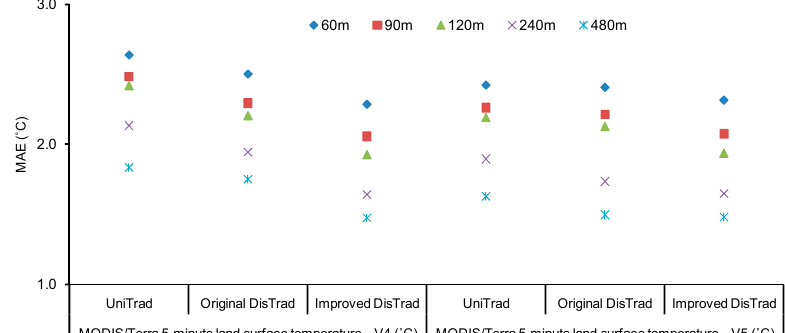
Figure 10. Mean Absolute Error (MAE) between downscaled products from MODIS/Terra 5-min land surface temperature (V4 and V5) using UniTrad, original DisTrad, and improved DisTrad, and observed Landsat 7 ETM+ land surface temperature at different resolutions (60, 90, 120, 240, and 480 m).